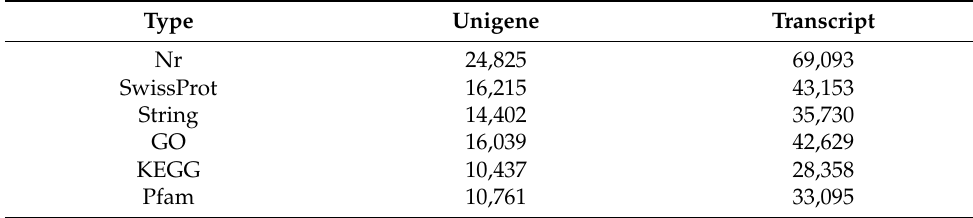
Table 3. Annotation statistics of T. mongolicum unigenes .